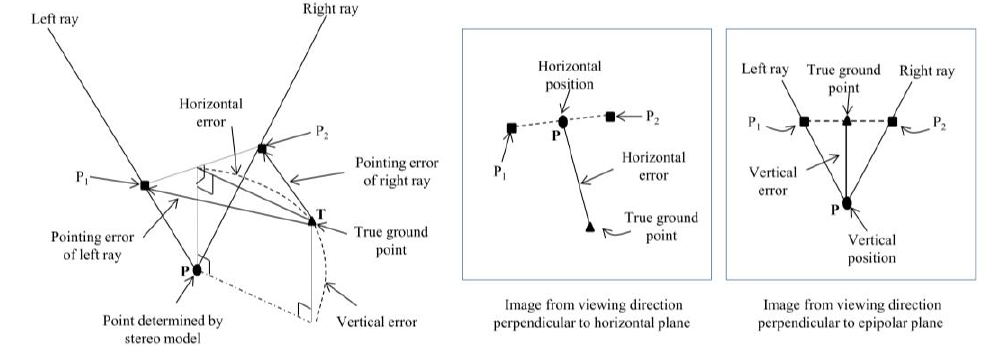
Figure 5. Stereo geometry layout in an ideal stereo geometry (Jeong and Kim, 2014).